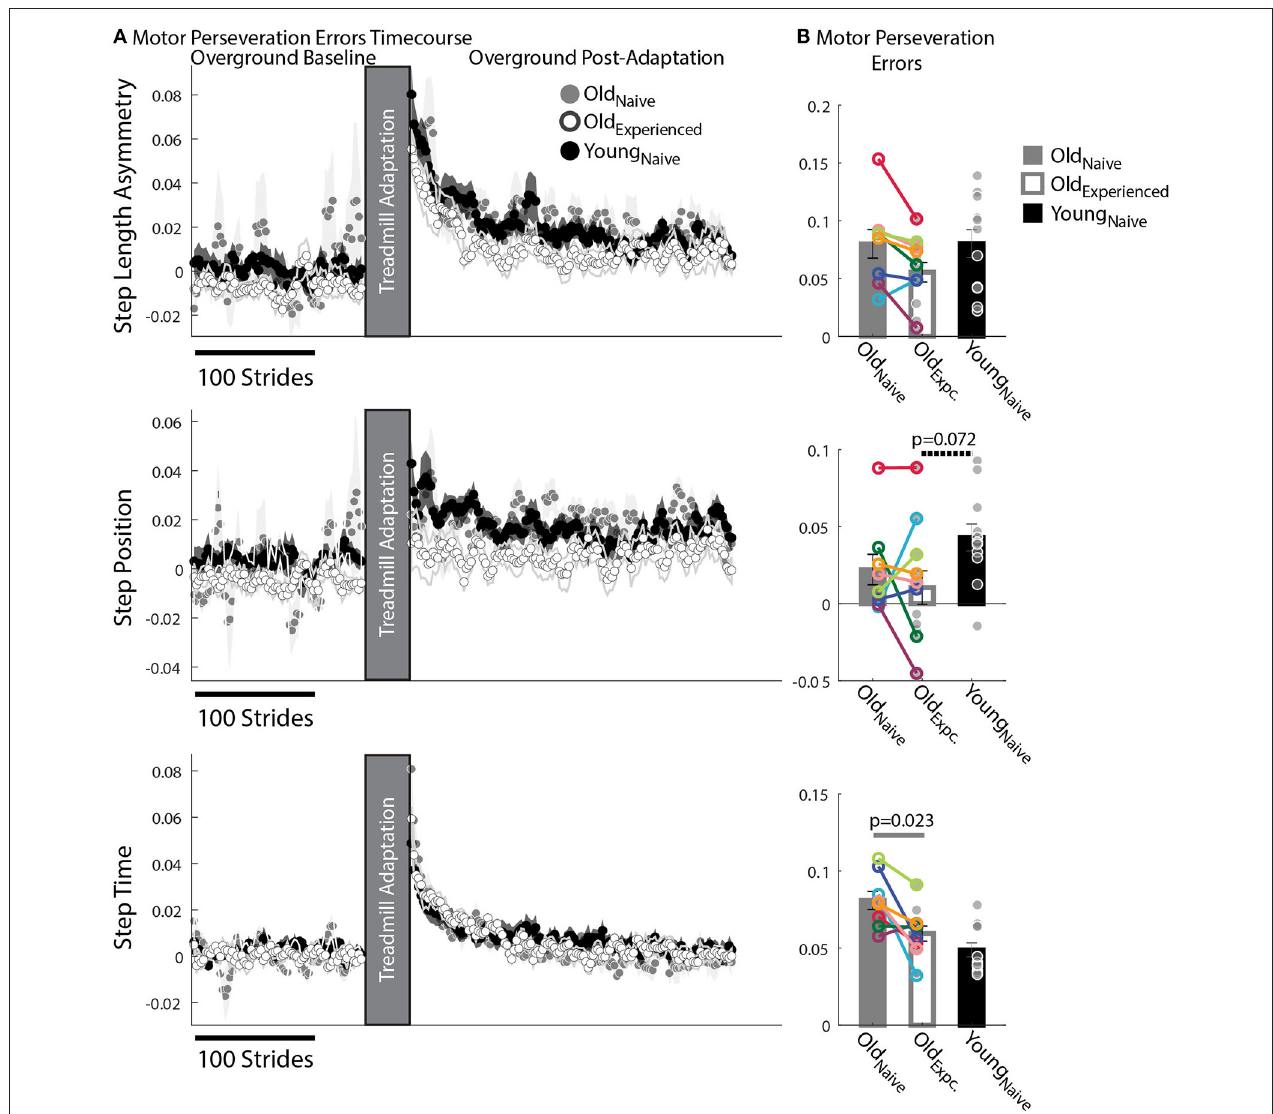
FIGURE 4 | Motor Perseveration During Overground Walking Following Split-Belt Walking. (A) Stride-by-stride timecourses of asymmetries in StepAsym, StepPosition, and StepTime when walking overground during Baseline and Post-Adaptation. Dots represent the average asymmetry values of 5 consecutive strides and colored shaded regions indicate the standard error for each group. (B) Motor Perseveration Errors: Bar plots indicate the group’s mean ± standard errors. Individual subject values are indicated with dots. Dots edged and connected with colored lines ( n = 8) indicate paired data from the Old nave and Old experienced testing sessions that were used for statistical testing to determine the effect of exposure. Gray dots ( n = 11) indicate unpaired data from the Old experienced and Young nave groups that were used for statistical testing to determine if older adults could behave like naïve, younger adults with exposure. Non-zero values indicate that participants cannot disengage the motor pattern acquired on the split-belt treadmill when walking overground. Older adults exhibited greater Motor Perseveration Errors in StepTime than in StepPosition compared to younger